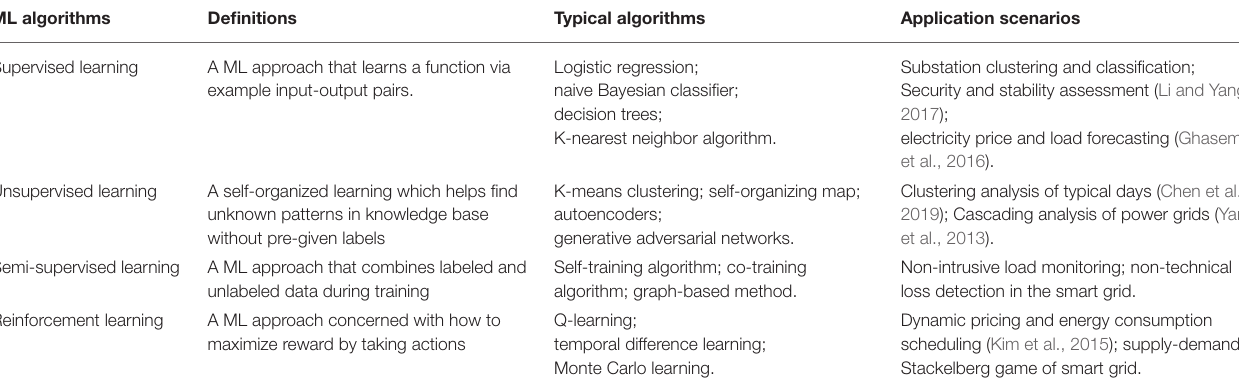
TABLE 1 | Summary of application of ML algorithms in smart